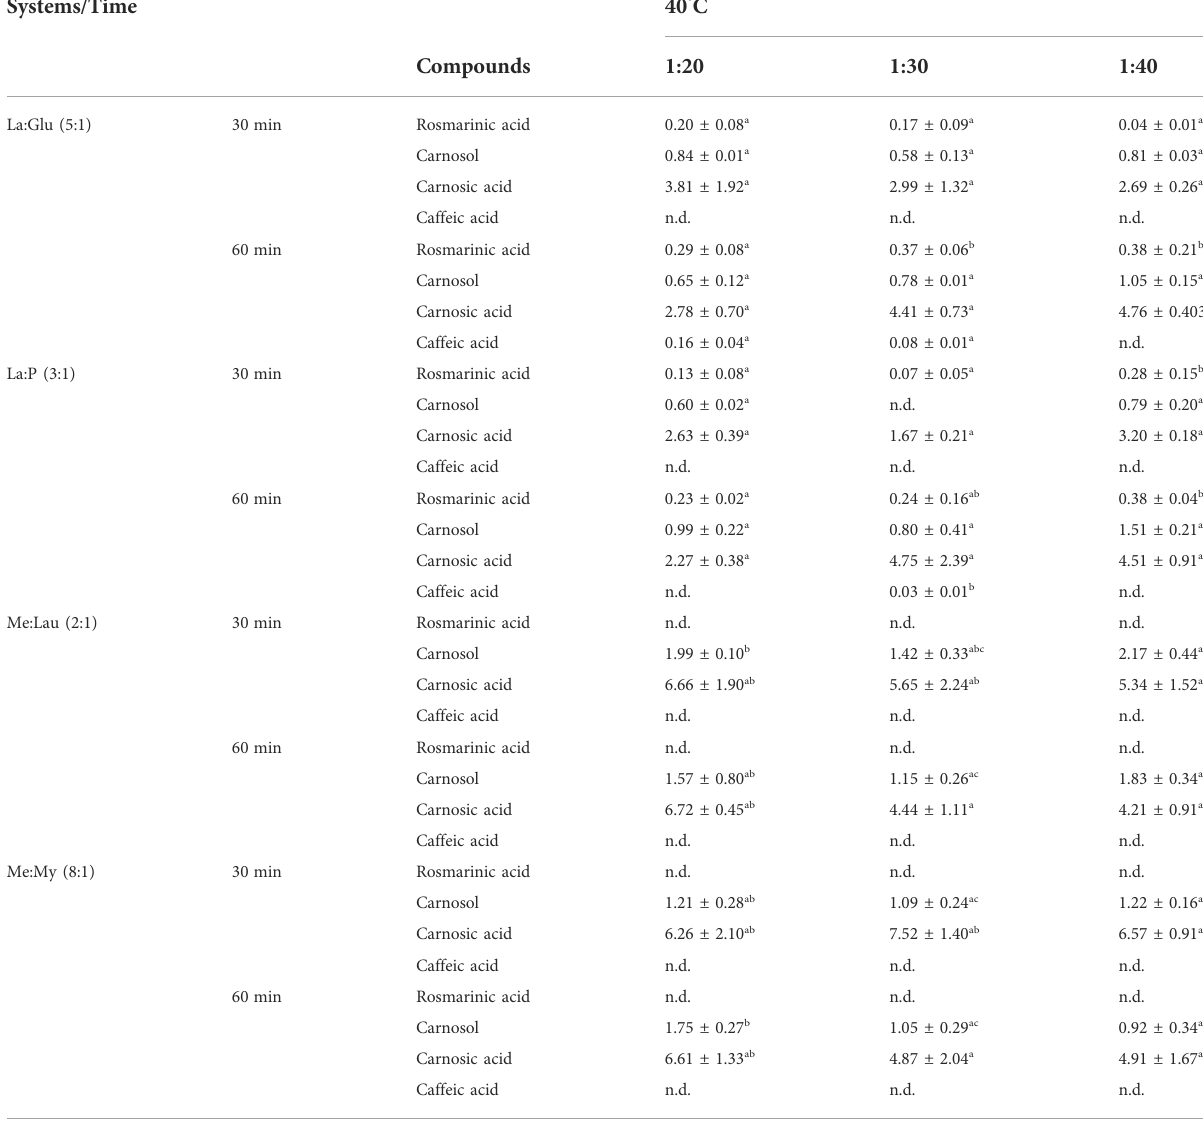
TABLE 5 Effects of UAE extraction time (30 and 60 min) and S:L ratio (1:20, 1:30, and 1:40) on the extracted content of each compound of interest fromrosemary:rosmarinicacid,carnosol,carnosicacid,andcaffeicacid(inmgofcompound/gofrosemary) at40 ° C.Theresultsareexpressedas mean ± SD. Statistically signi fi cant differences between the ratios (1:20, 1:30, and 1:40) in each system are represented by letters. Different letters indicate signi fi cant differences within each system.